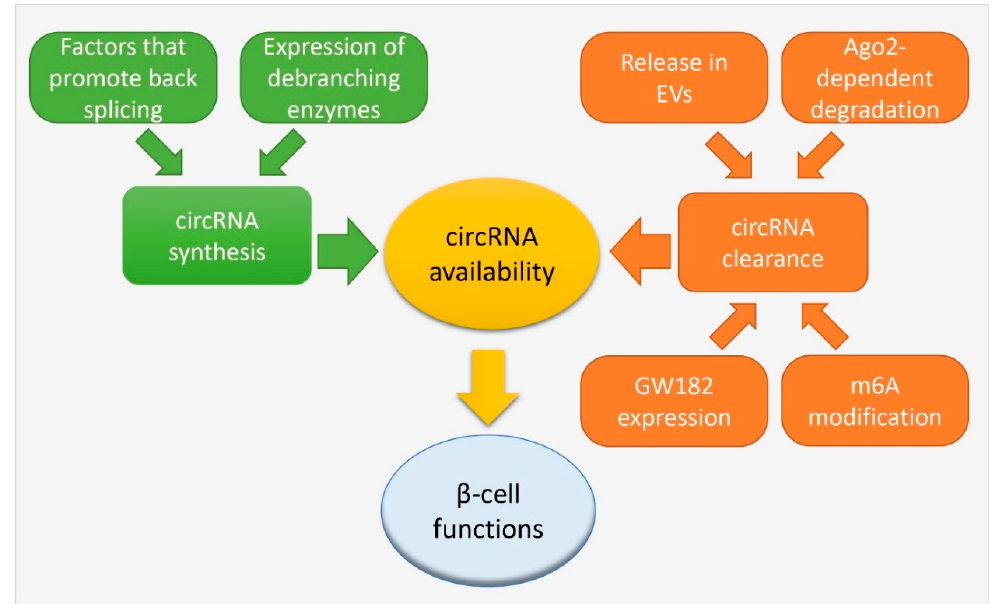
Figure 4. Known mechanisms regulating circRNA availability. CircRNA availability is driven by a complex network of factors regulating both their synthesis and clearance from the cell. CircRNA synthesis depends on specific components that promote back splicing, and on the expression of debranching enzymes that regulates the degradation of lariats. On the other hand, circRNA clearance from the cells can occur through different mechanisms of degradation: Ago-2-dependent degradation, m6A-triggered degradation, and GW182 expression. Furthermore, the active secretion of circRNAs through extracellular vesicles (EVs) can be a possible mechanism for circRNA clearance. The availability of specific circRNAs inside the pancreatic β -cells can affect their key functions.